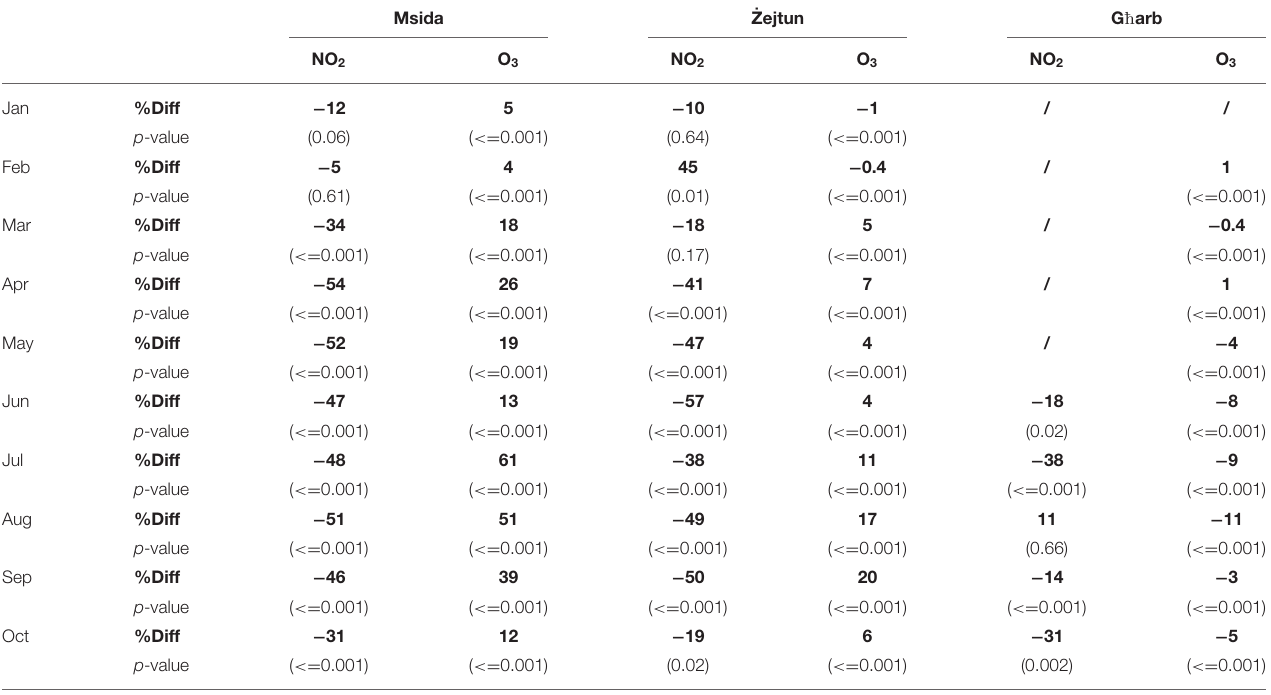
TABLE 2 | Monthly mean percentage differences between predicted and measured pollutant concentrations as well as p -values for all three sites.